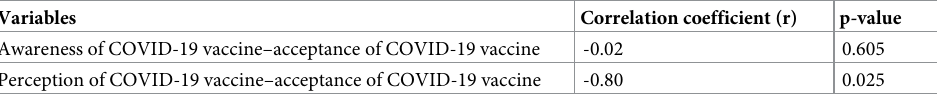
Table 5. Correlation between acceptance of COVID-19vaccine with awareness and perception of vaccine.